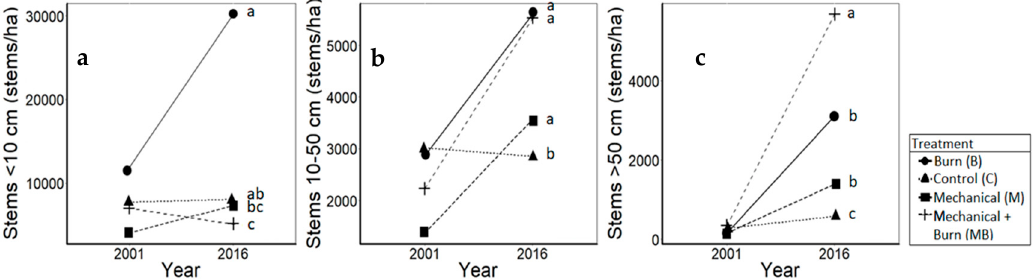
Figure 6. Mesic hardwood primary guild a ) stem density (stems/ha), b ) absolute cover (%), and c ) importance value results showing the 4 treatment effects (control = C, burned = B, mechanical removal of stems <10 cm in diameter at breast height (DBH) = M, and mechanical removal of stems <10 cm DBH + burned = MB) from 3 analysis of variance (ANOVA). Post-hoc comparison (Tukey’s Honest Significant Di ff erence Test, THSD) letters show di ff erences between treatment e ff ects from 2001 to 2016.